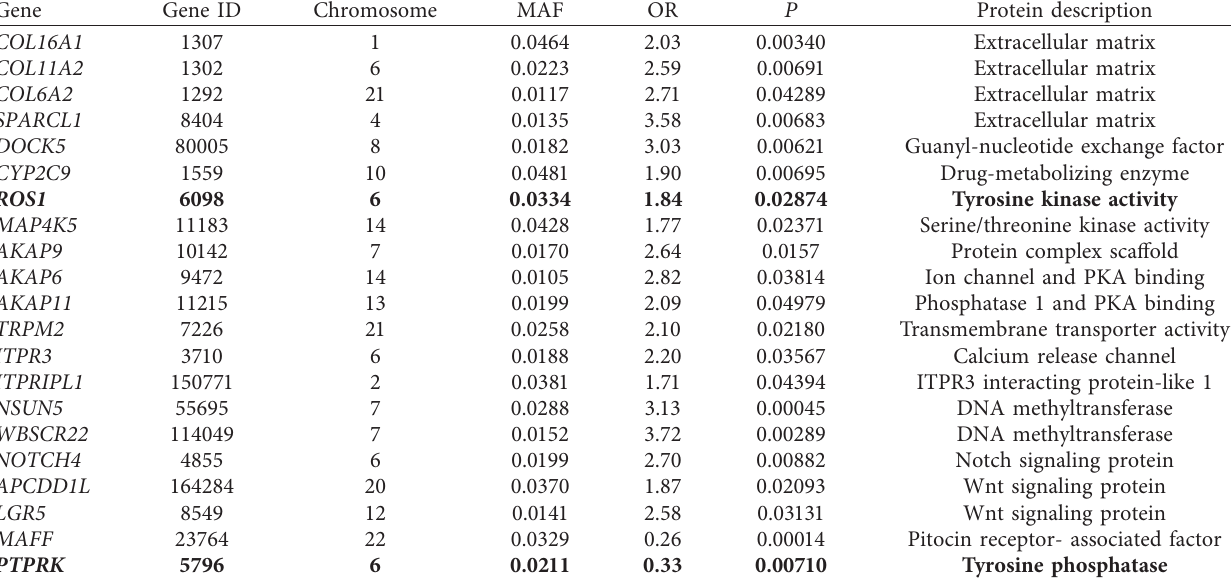
Table 2: 21 susceptibility genes associated with PE in exome sequencing.